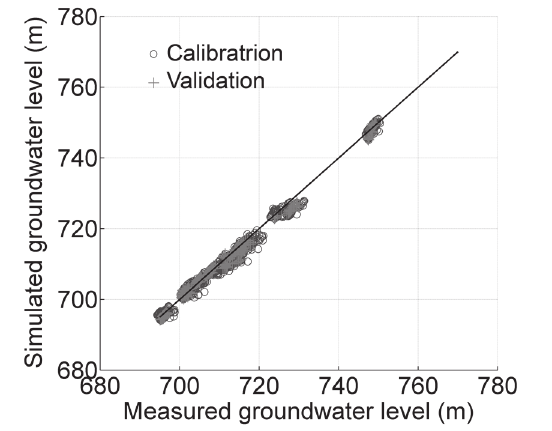
Figure 7 - Comparison of measured water levels and water levels simulated by SPA transient groundwater model during calibration (circle) and validation (cross) periods.